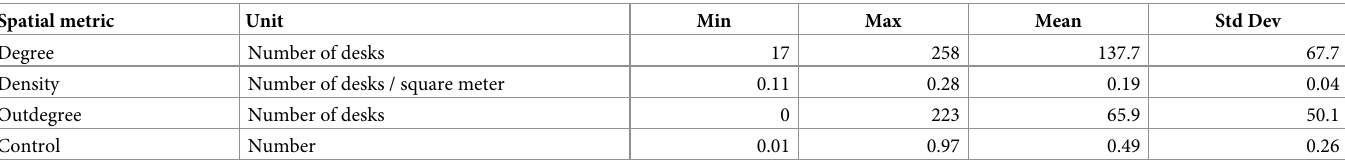
Table 1. Descriptive statistics for all continuous spatial metrics including minimum, maximum and mean values as well as standard deviation; sample size n = 167 desks (five survey responses contained missing information on seat type and were excluded from the analysis). Spatial